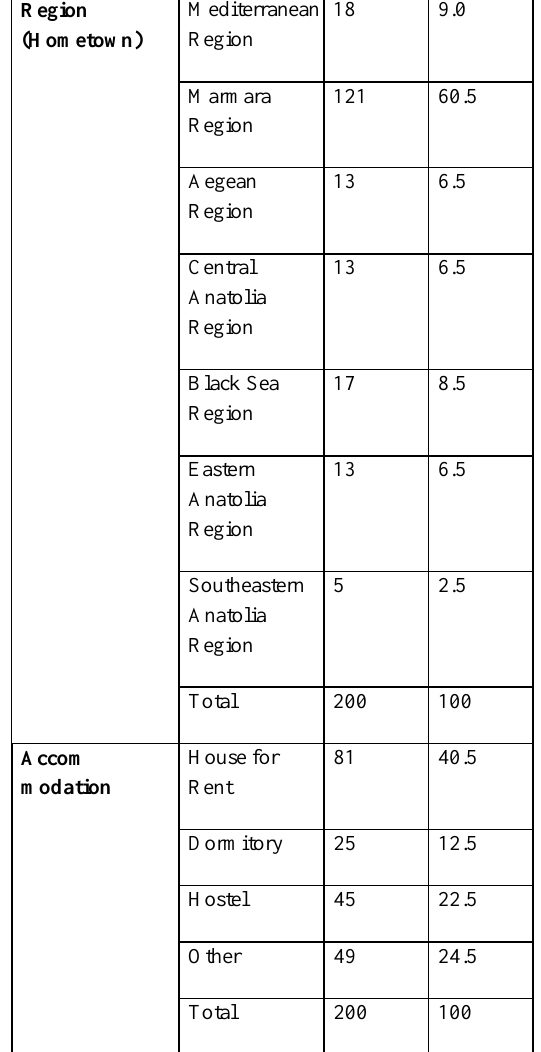
Table 2 related to demographic